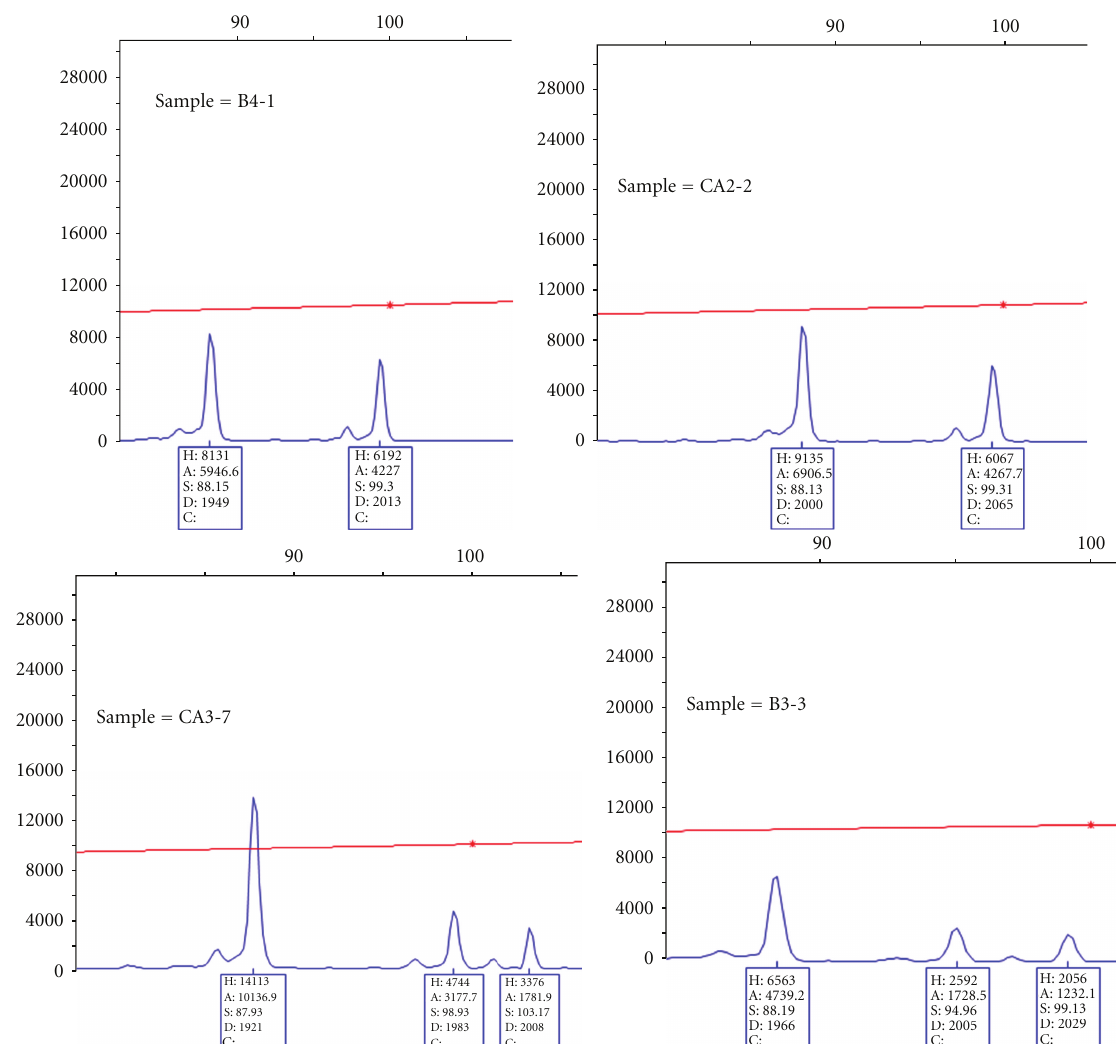
Figure 1: The electrophoretogram showing the alleles at the SSR locus Sat207